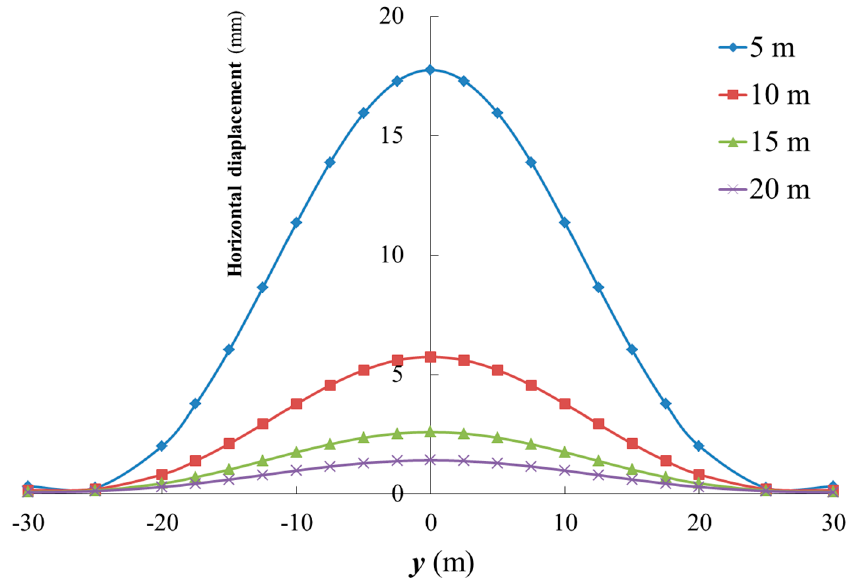
Figure 11. The influence of the grouting distance on the compensated level of horizontal displacement of the tunnel.